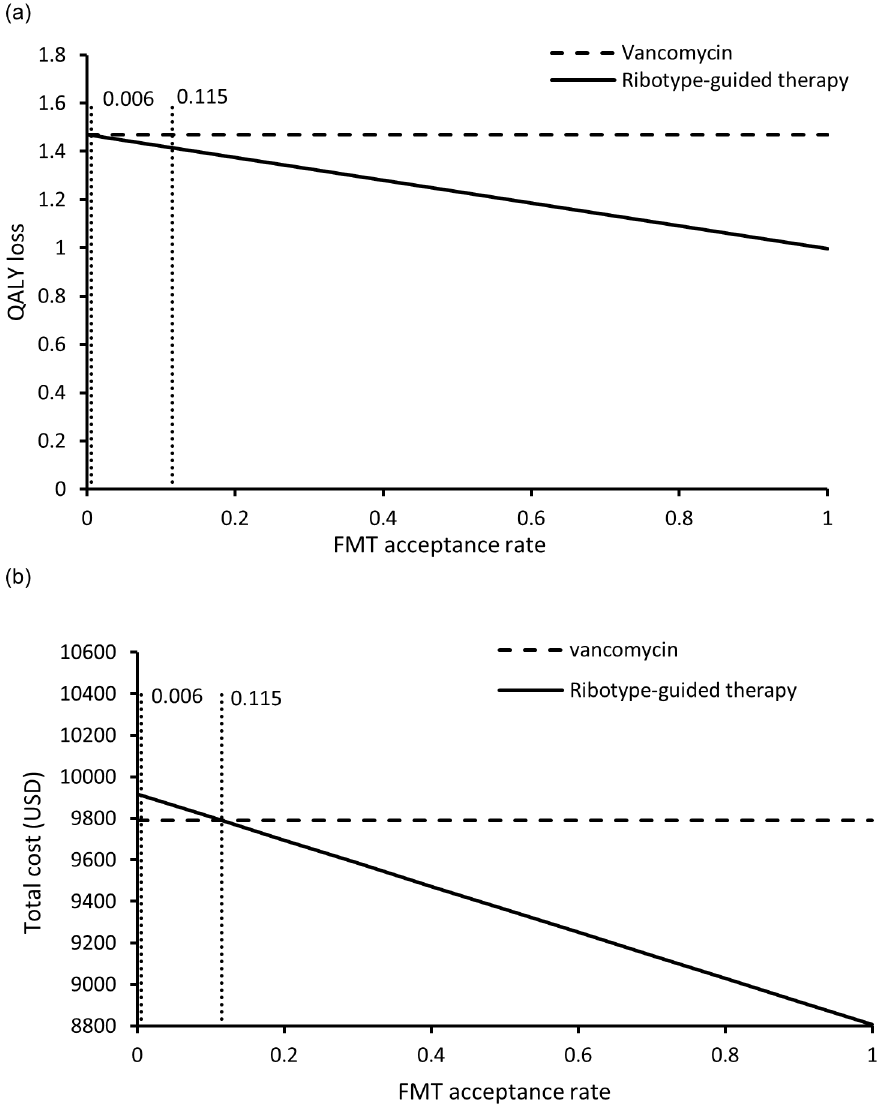
Fig 2. QALYs loss (a) and total cost (b) of each strategy against variation of patient acceptance rate to